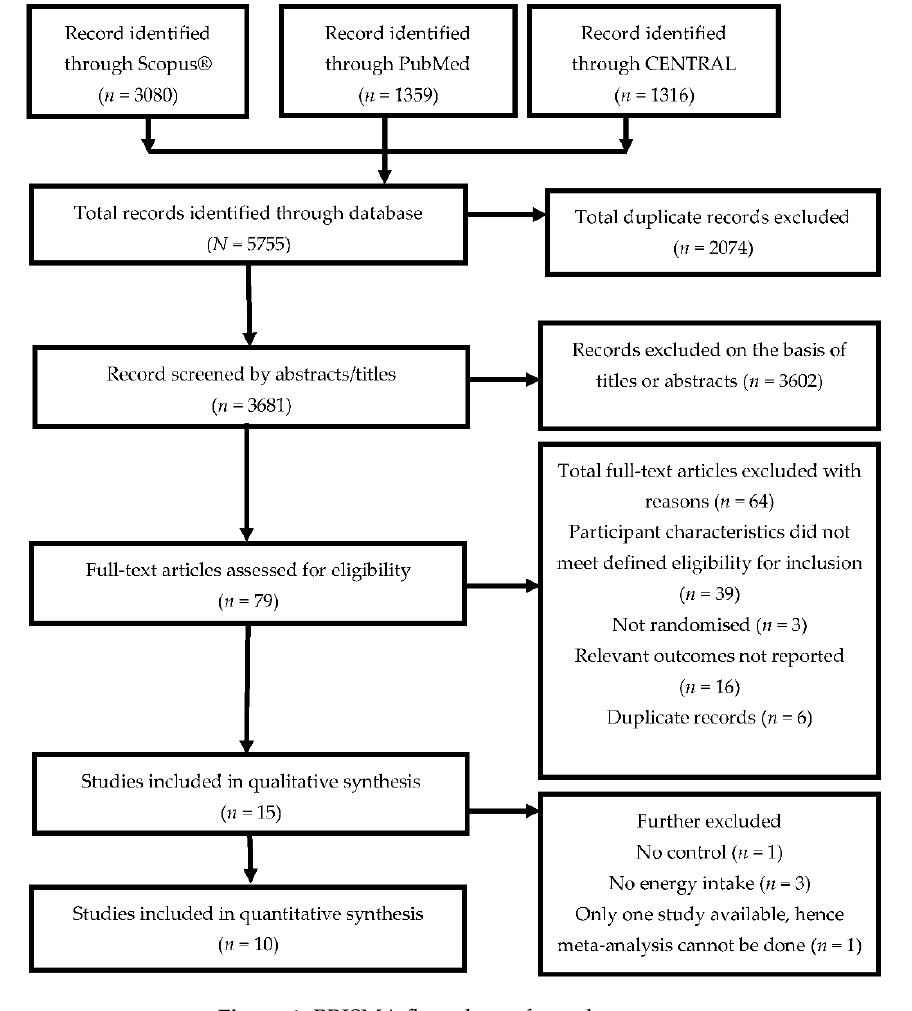
Figure 1. PRISMA flow chart of search strategy.